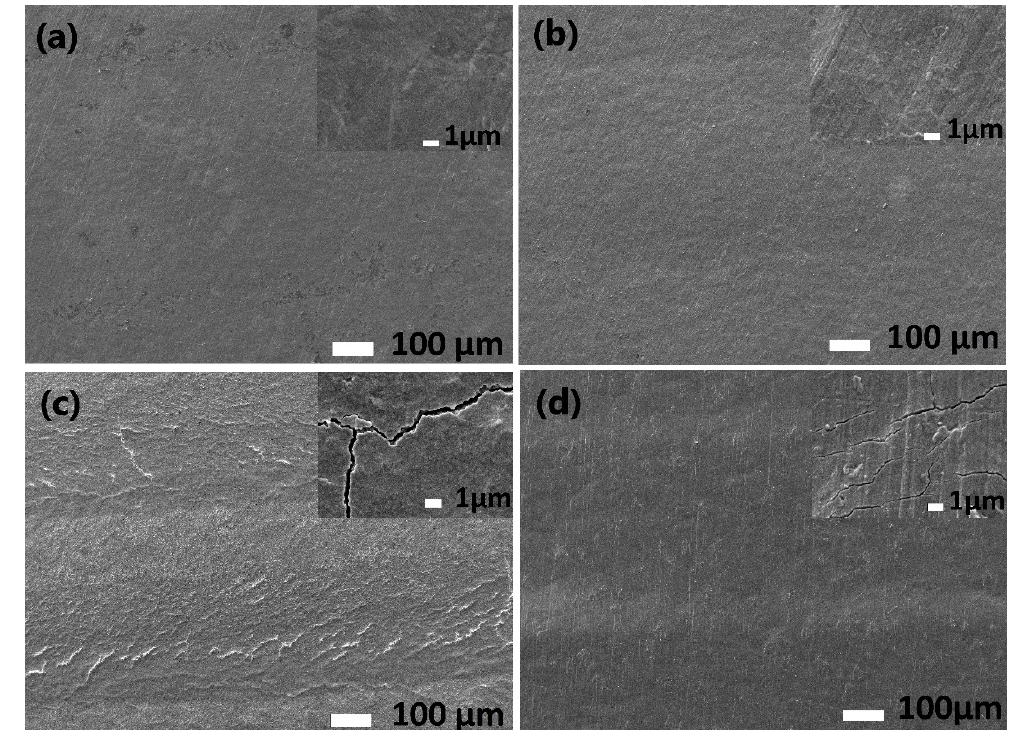
Figure 3. Microstructure of ( a ) LT1 sample blue area, ( b ) LT1 sample yellow area, ( c ) LT2 sample and ( d ) LT3 sample.